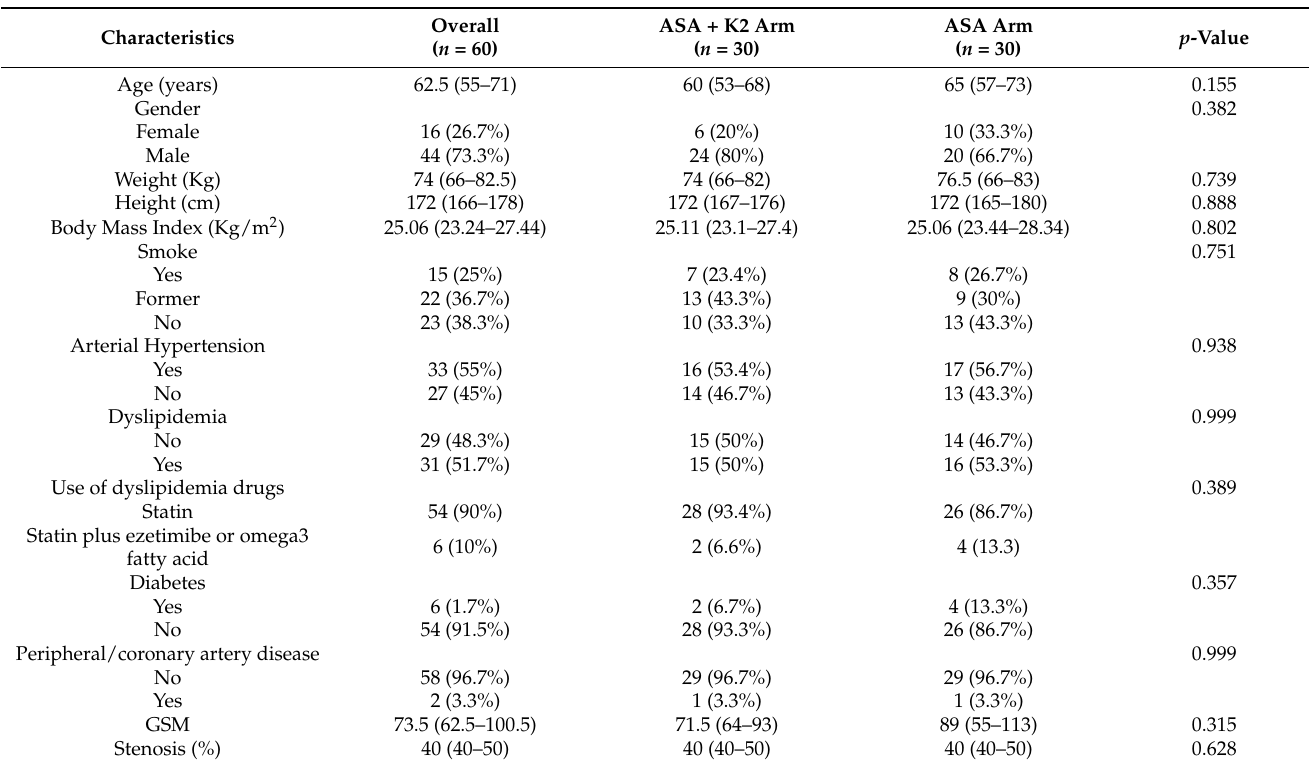
Table 2. Baseline patient’s clinical characteristics.